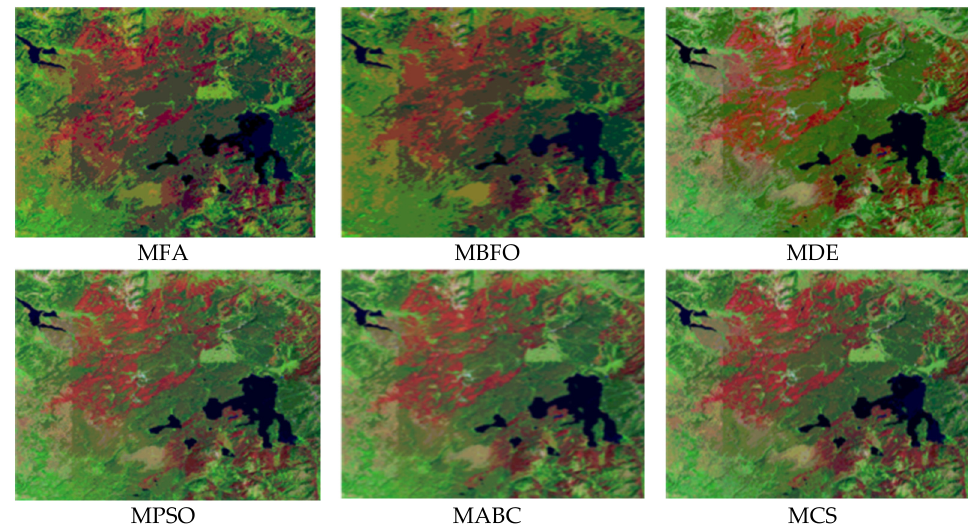
Figure 13. GLCM-based segmented images using MFA, MDE, MPSO, MABC, and MCS for thresh- olding level 8.